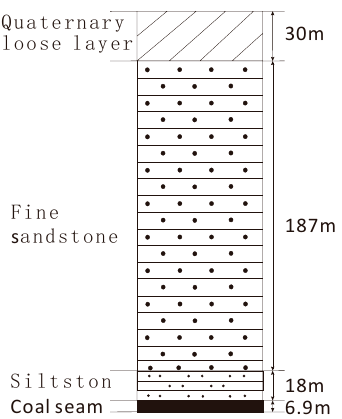
Figure 1 . The section figure of the 52303 work facing. Figure 1. The section figure of the 52303 work